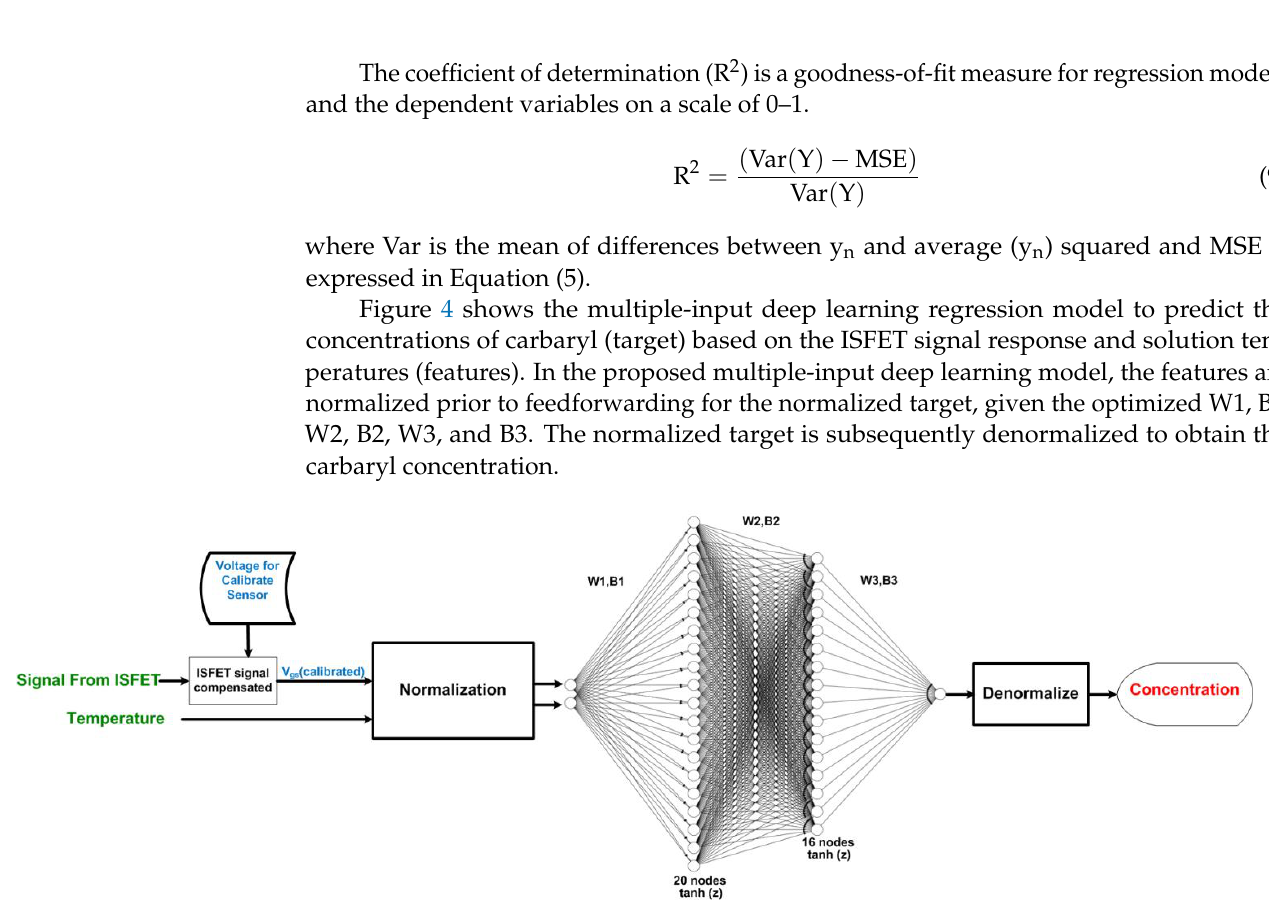
Figure 4. The process of signal implementation on the multiple-input deep learning regression-based model for predicting the pesticide concentration.